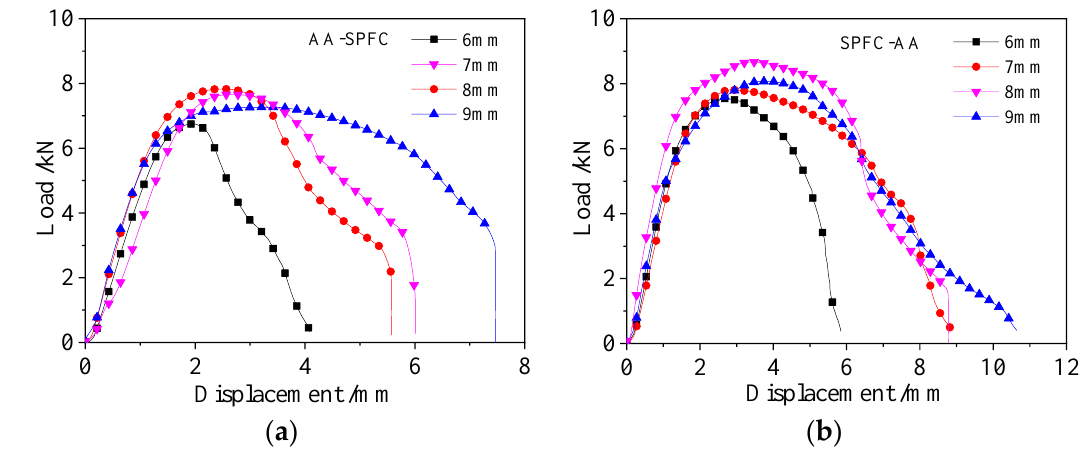
Figure 7. Displacement – load curves of SPR joints: ( a ) AA-SPFC joints; ( b ) SPFC-AA joints. The static tensile curve can be divided into three stages. In the initial stage of the tensile test, the tensile load increases linearly with the increase of displacement. The SPR structure undergoes elastic deformation at this stage. The slopes of the displacement–load curves hardly change with the rivet height when the laying order of metal sheets is fixed. The slopes of SPFC-AA specimens are higher than that of the AA-SPFC specimens. As discussed earlier, the length of the internal lock and the expanding degree of the rivet leg of the SPFC-AA joints are larger than those of AA-SPFC joints, so the SPFC-AA joint has stronger self-locking ability and a tighter joint. It is also shown in reference [15] that the displacement–load curve has a higher slope because of its tighter structure. The slope of the displacement–load curve with the 8 mm rivet is slightly higher than that of the other curves for the SPFC-AA specimens, which is due to the tighter contact between the rivet and the metal sheets (Figure 6c). The metal does not fill the rivet cavity when the rivet height is 6 mm (Figure 6a) and 7 mm (Figure 6b), which results in a large gap in the rivet inner cavity. There is a big gap between the rivet head and the upper sheet when the rivet height is 9 mm (Figure 6d).